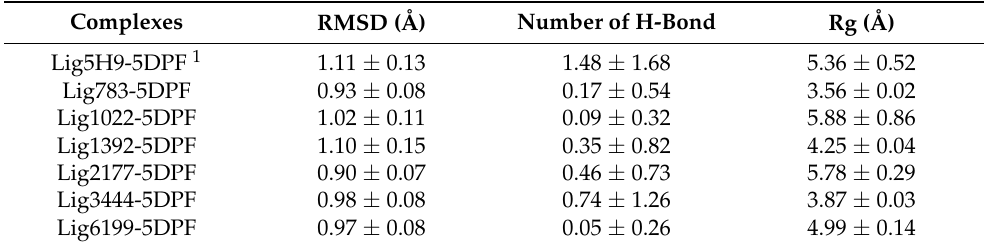
Table 2. Average values and standard deviation of parameters taken from 50 ns of